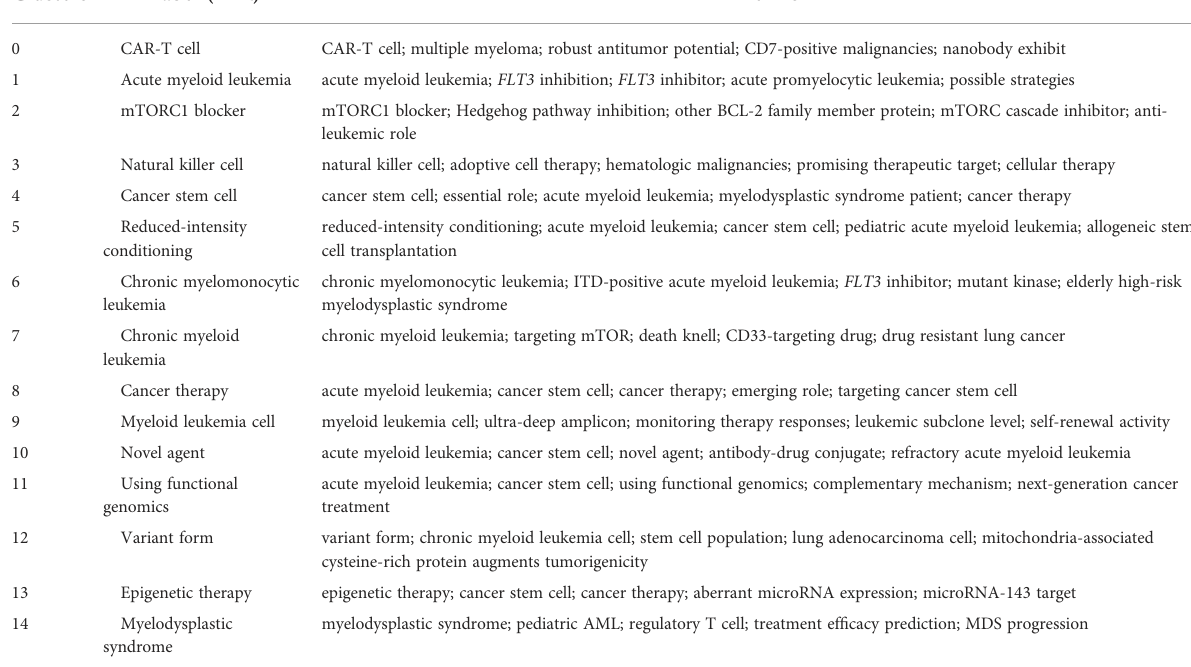
TABLE 1 The information of clusters about keyword co-citation analysis.